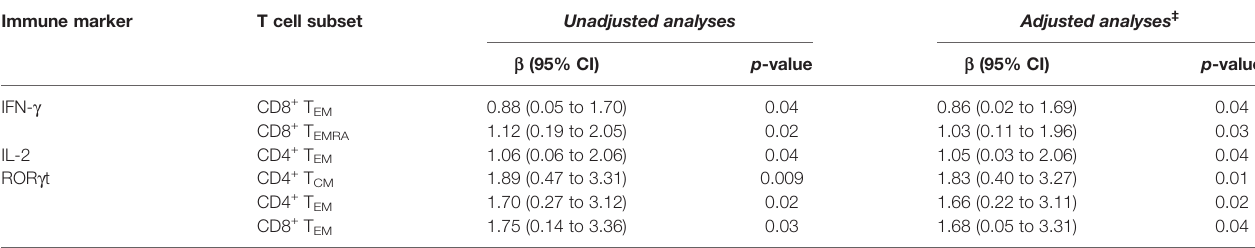
TABLE 3 | The association of the absence of RSV infection in infancy with memory T cell responses at ages 2-3 years after in vitro stimulation with RSV. * Immune marker T cell subset Unadjusted